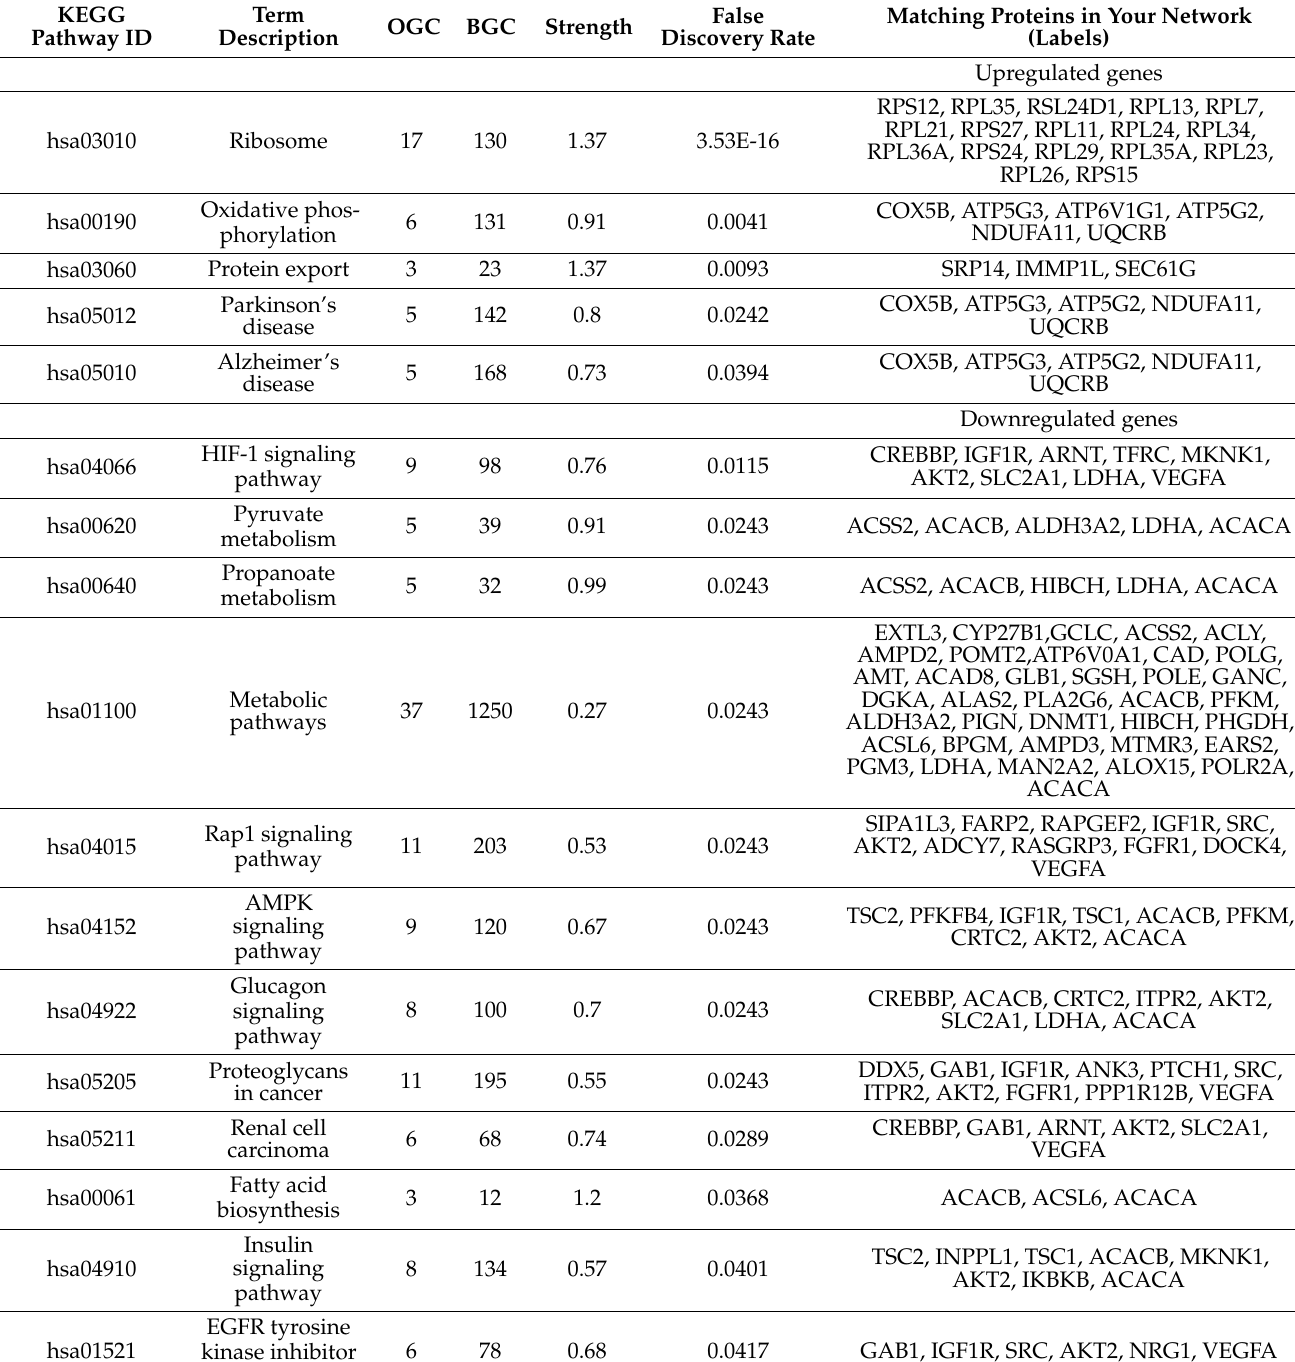
Table 5. Associated KEGG pathway enrichments of the significantly up- and downregulated